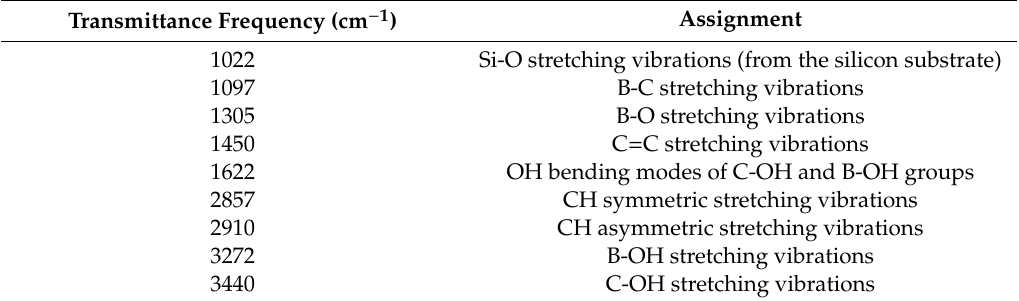
Figure 6. Fourier transformed infrared spectroscopy spectral analysis of the ( a ) BC-1 and ( b ) BC-2 samples. Table 2. Complete peak assignment for the Fourier transformed infrared spectroscopy (FTIR) spectral analysis of the BC-1 coating.